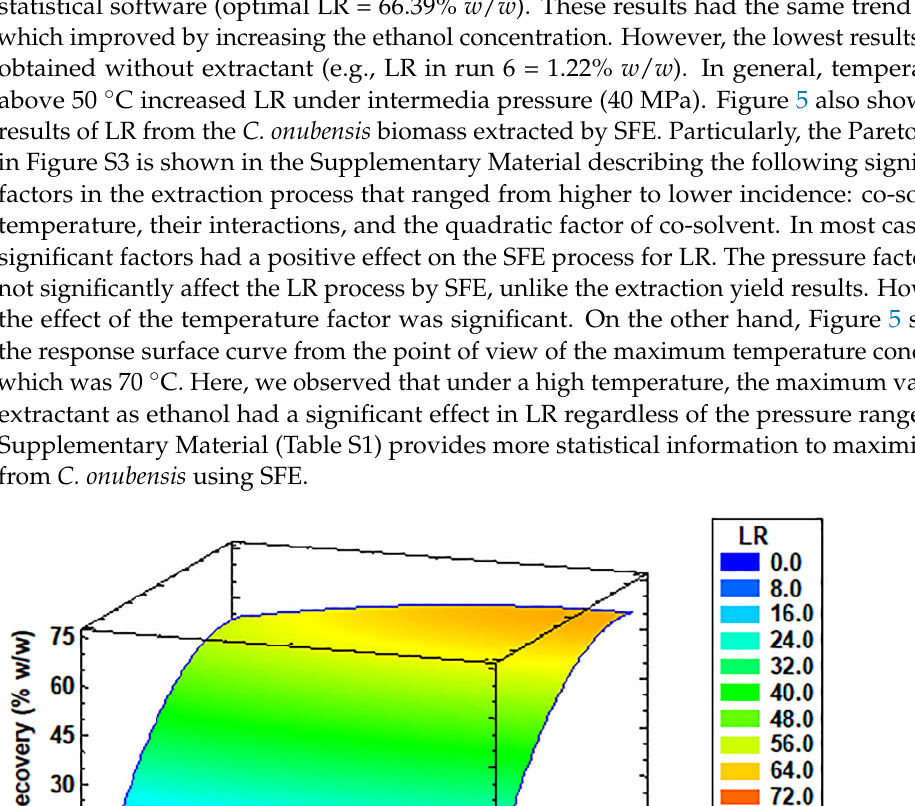
green extraction technology is being used in microalgal research. For instance, in a study performed by Molino et al. [58], CO 2 supercritical fluid was used to perform astaxanthin and lutein extraction from Haematococcus pluvialis (red phase), with different variables